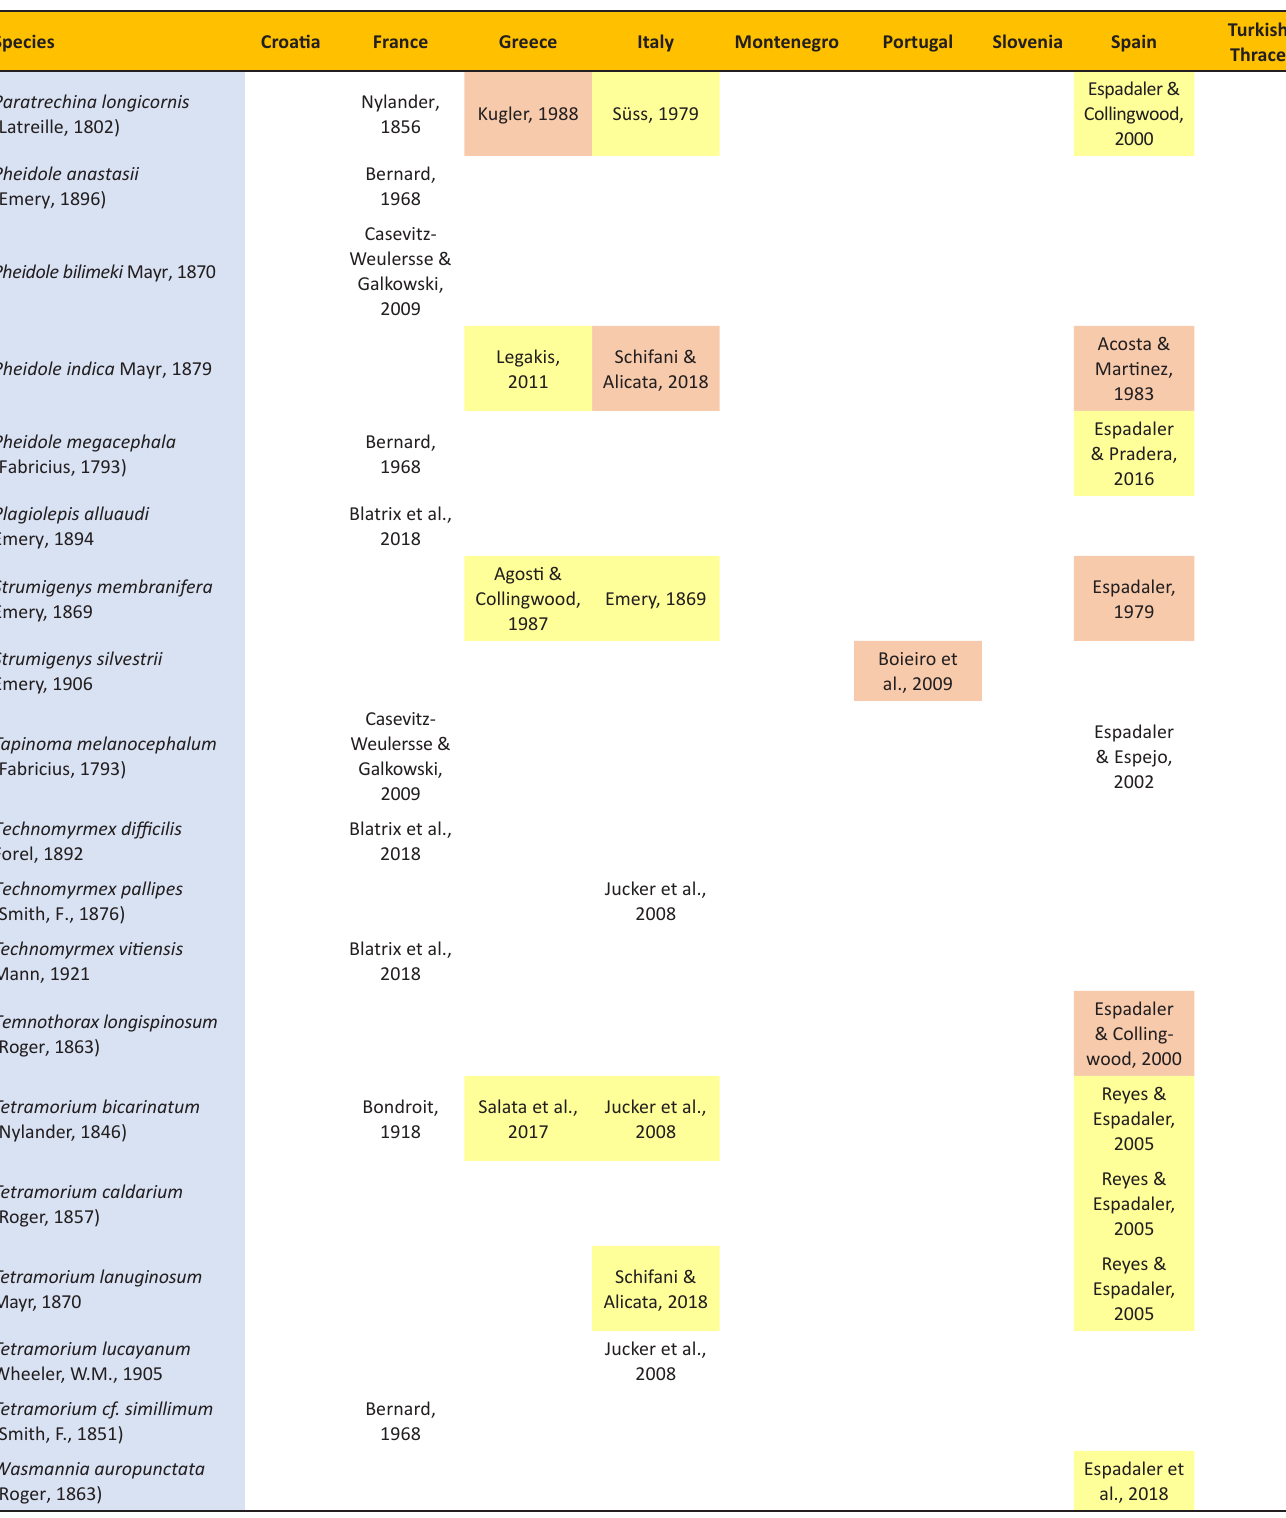
Table 1 . Exotic ant species established or seemingly established in France (Corsica, mainland), Greece (Crete, mainland, Peloponnese), Italy (mainland, Sardinia, Sicily) and Spain (mainland). The first confirmed record of the species in each country is presented on the right of the species name. Species that have been found outdoors are marked in yellow, species that have also colonized areas outside urban contexts are marked in red.